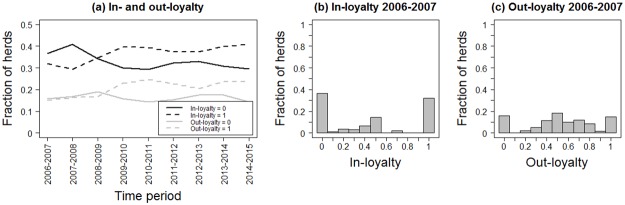
In- and out-loyalty patterns.(a) Fraction of holdings with in-loyalty and out-loyalty equal to 0 and 1 for the whole network of pig movements from 1st January 2006 to 31st December 2015 in Denmark. (b) and (c) show the histograms of in- and out-loyalty for the two consecutive years 2006 and 2007. Both histograms refer to the years 2006 and 2007 for visualization purposes, all other distributions show stability over time and are shown in in S2 File.